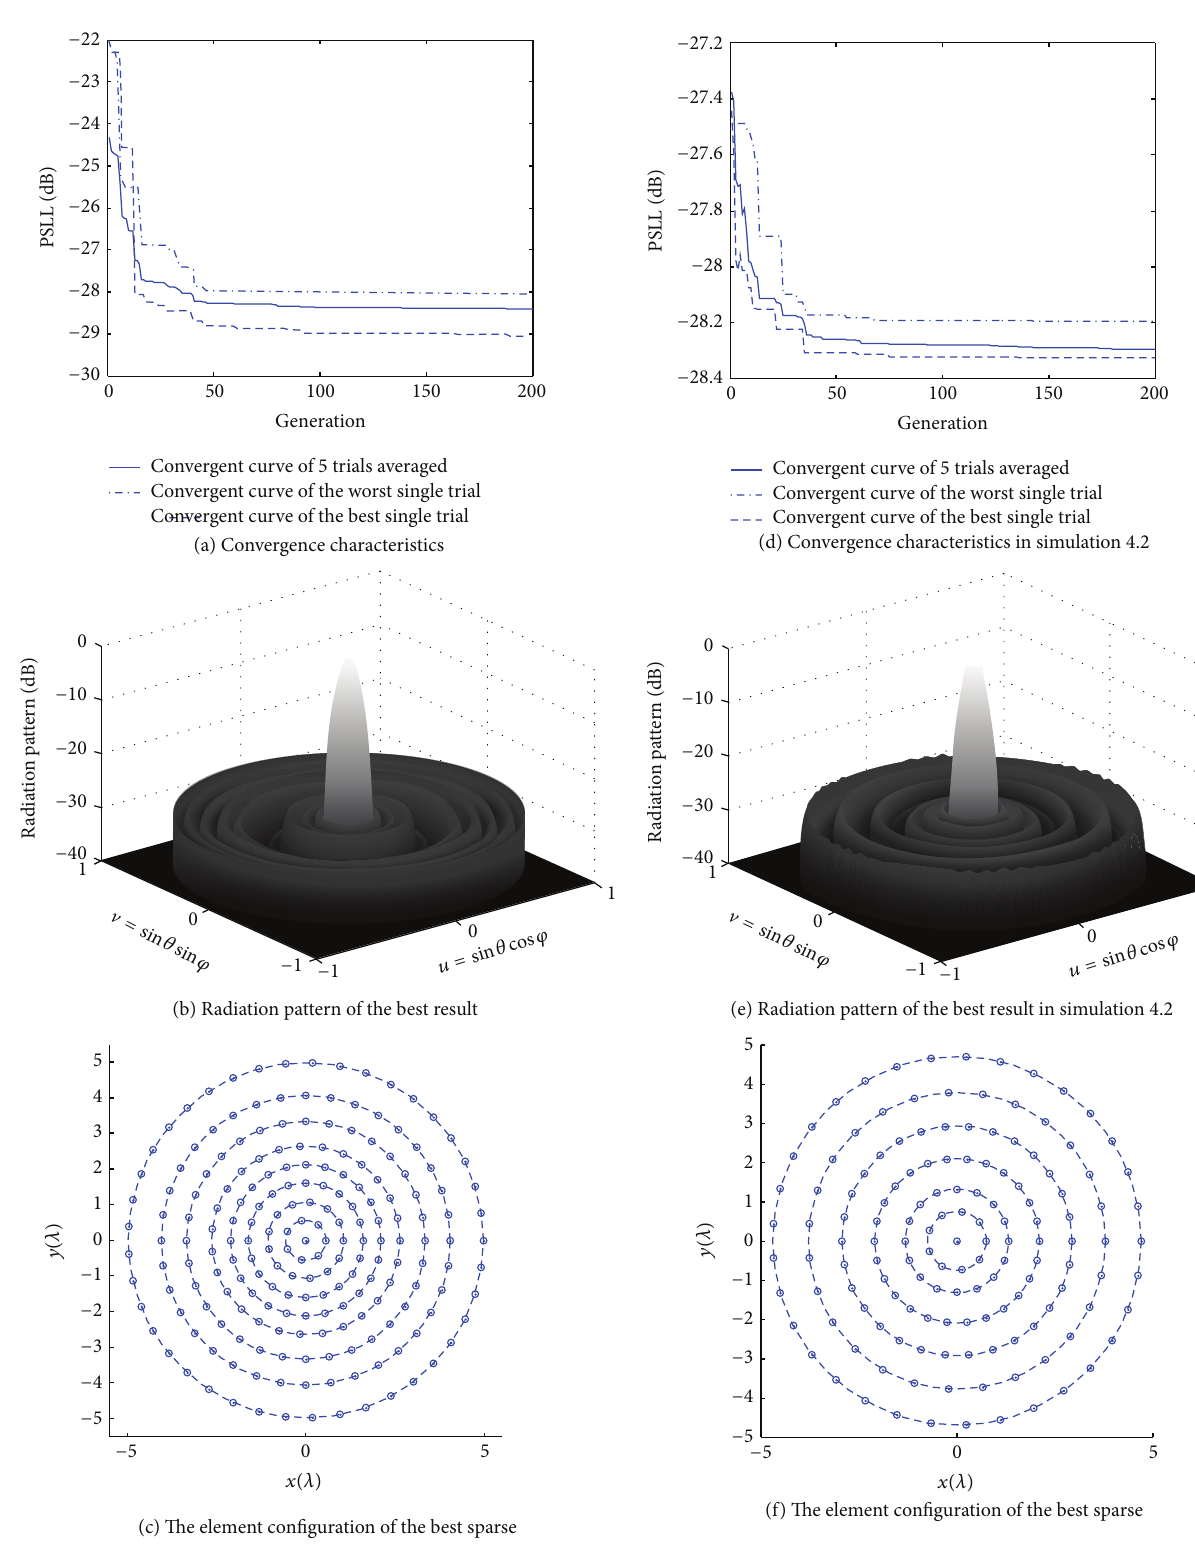
Figure 2: Convergence characteristics, element configuration, and radiation pattern for the sparse concentric ring